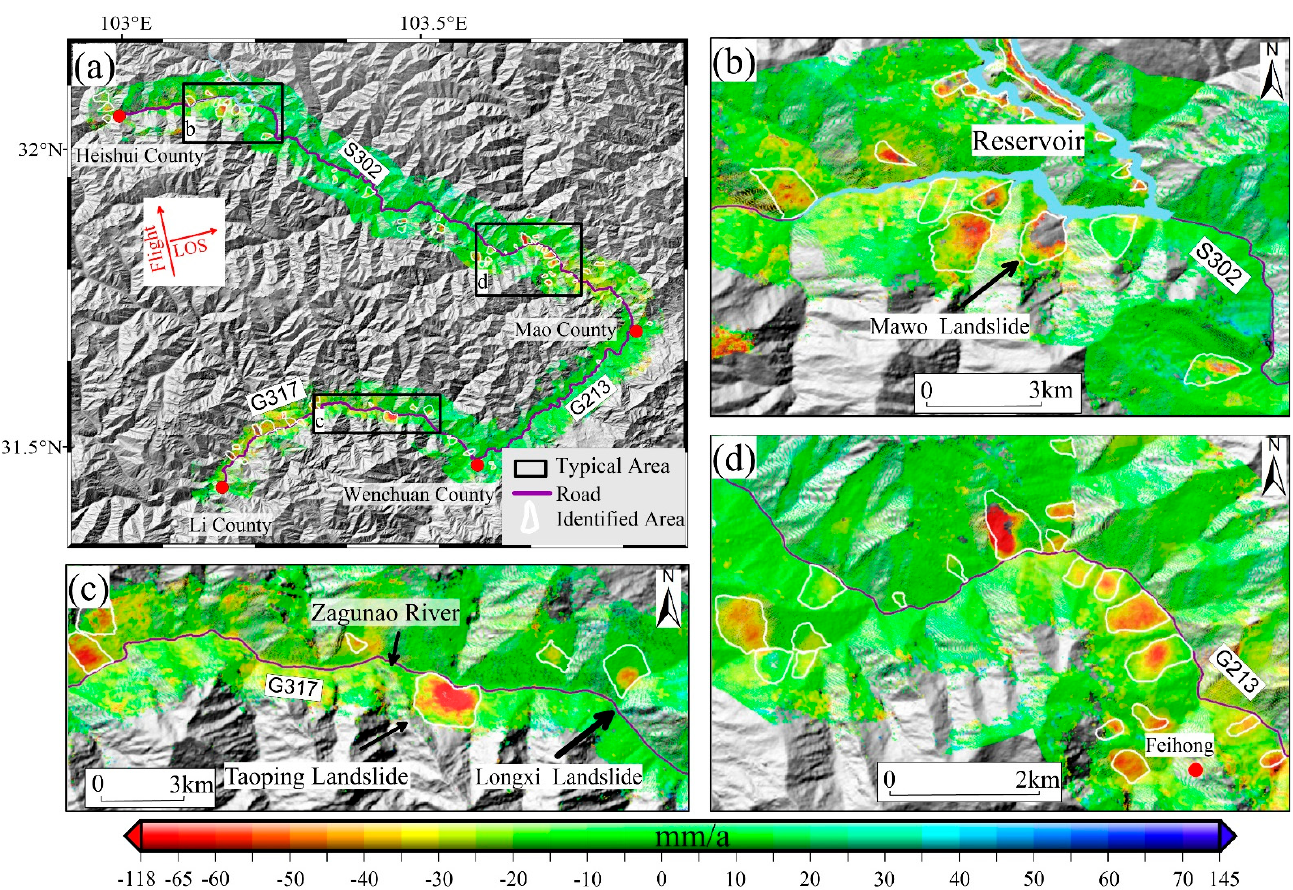
Figure 5. ( a ) SBAS-InSAR results in the whole study area; ( b - d ) Enlarged show of the three typical area in ( a